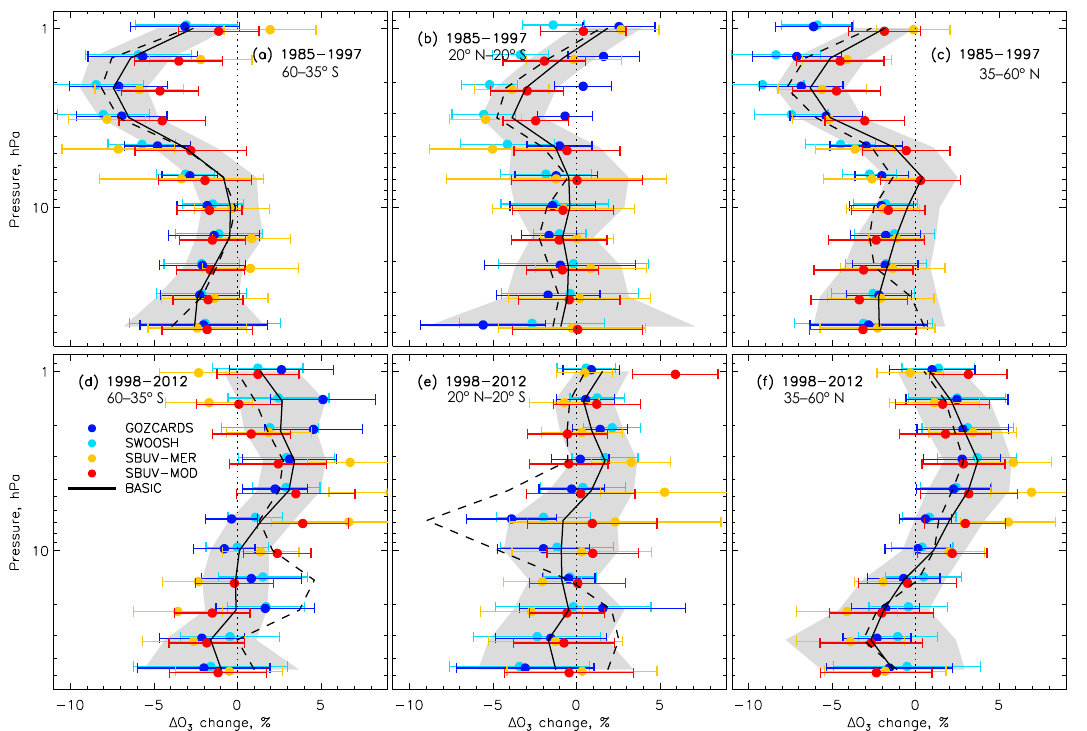
Figure 8. The percentage change in ozone from DLM between 1985 and 1997 (a–c) , and 1998 and 2012 (d–f) , over 60–35 ◦ S (a, d) , 20 ◦ S– 20 ◦ N, and 35–60 ◦ N (c, f) . GOZCARDS, SWOOSH, SBUV-MER, and SBUV-MOD are shown with error bars representing 95% credible intervals; for the BASIC composite (black), shading represents uncertainties. The mean linear trend estimate from MLR for the BASIC composite is given as a black dashed line (no uncertainties) and is the scaled version of the MLR-BASIC decadal trend shown in Fig.